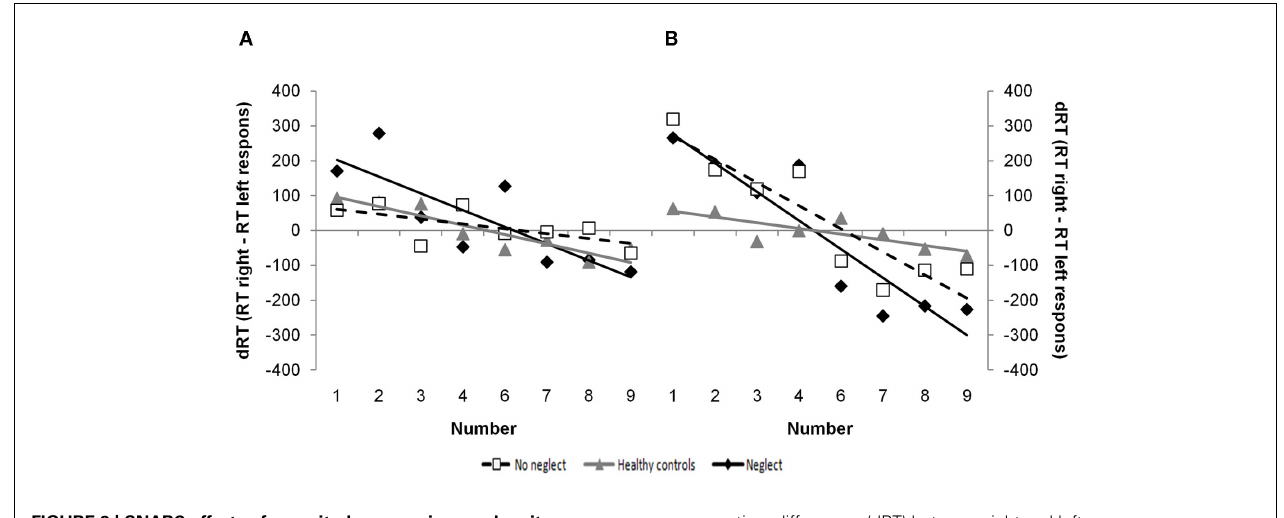
FIGURE 2 | SNARC-effects of magnitude comparison and parity judgment in neglect patients, patients without neglect and healthy controls. The observed data and the regression line represent the